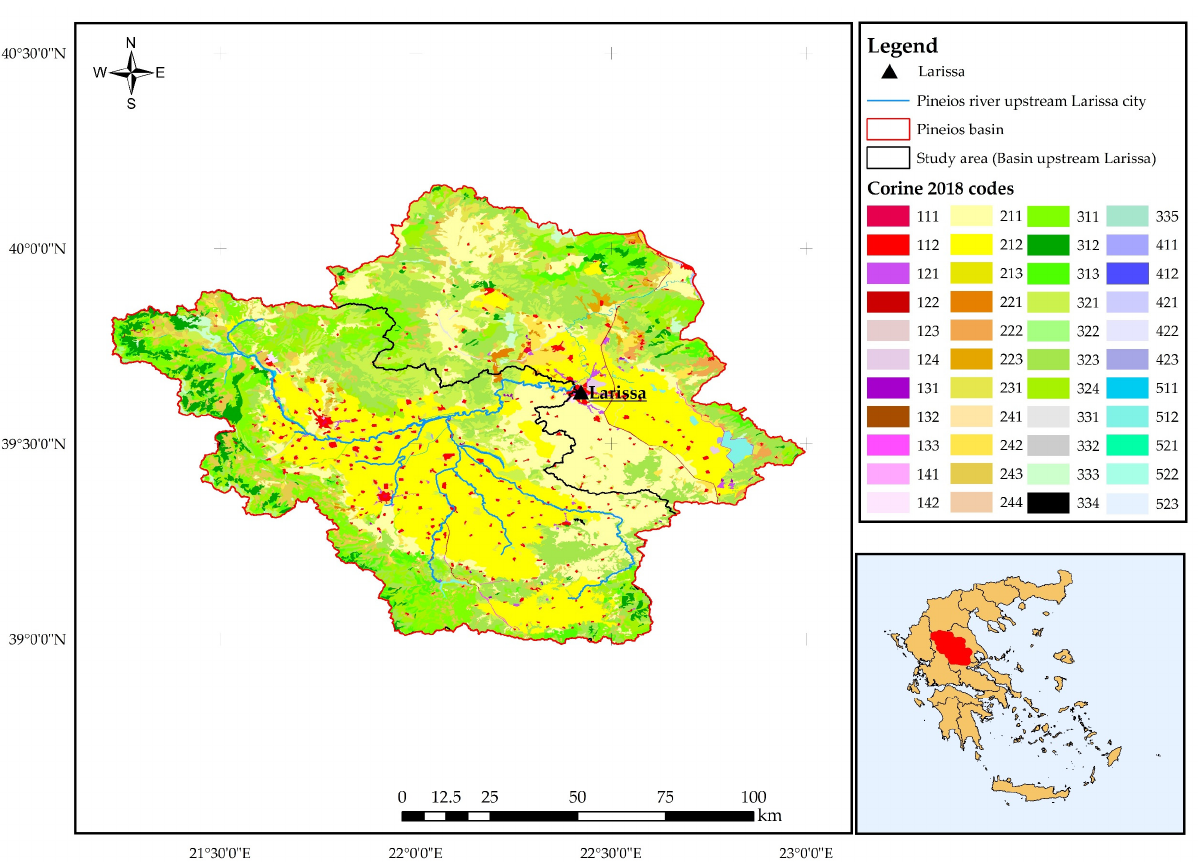
Figure 2. Pineios basin and study area, Pineios catchment upstream of Larissa city in Greece. The CMORPH rainfall reanalysis dataset [40] was utilized, as it has the highest spa- tial (8 km × 8 km) and temporal resolution (30 min) and the longest available record (1 January 1998–31 December 2019). Data were downloaded from the data server of